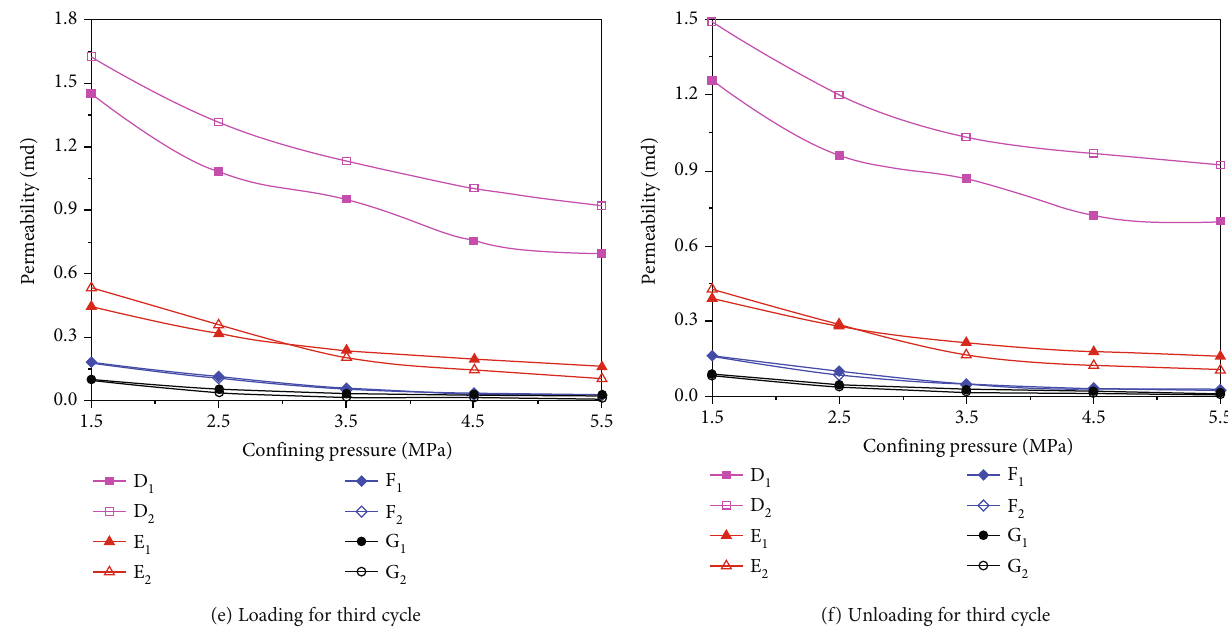
Figure 10: Permeability di ff erences of samples under di ff erent con fi ning